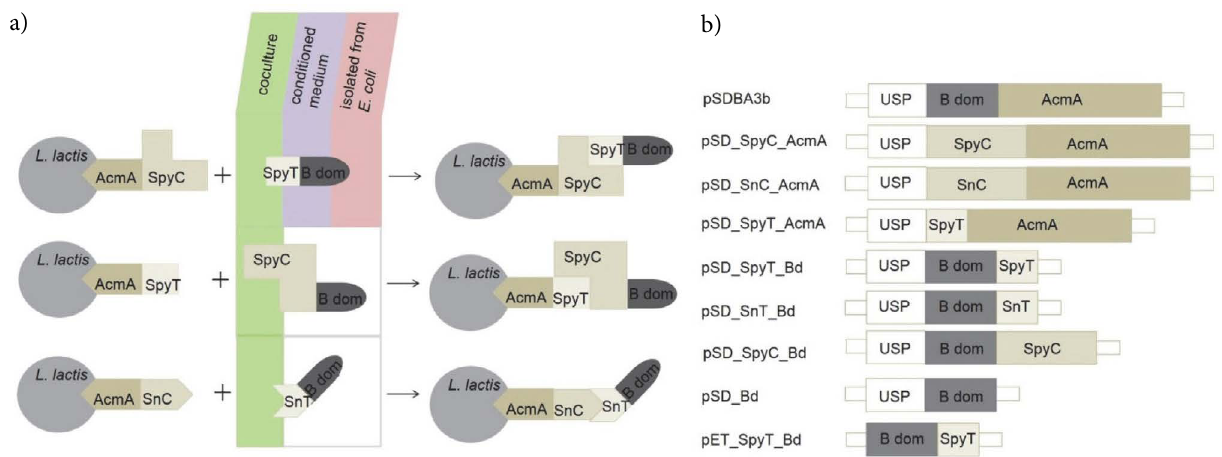
Fig. 1. The principle of surface display of B domain on L. lactis by the formation of isopeptide bond (A), and the gene constructs prepared for its implementation (B). A: Surface displayed SpyCatcher (SpyC), SpyTag (SpyT), or SnoopCatcher (SnC), all anchored via AcmA on L. lactis, bind fu- sion proteins consisting of SpyT, SpyC, or SnoopTag (SnT), respectively, and B domain. The fusion proteins were produced by L. lactis co-culture, were extracted from L. lactis conditioned medium, or were isolated from E. coli . B: Gene constructs for lactococcal surface display and isopeptide bond formation. USP: gene for Usp45 signal peptide for secretion to the growth medium (84 bp). B dom: gene for reporter protein B domain of staphylococcal protein A (174 bp). SpyC: gene for protein SpyCatcher which binds SpyT (348 bp). SnC: gene for protein SnoopCatcher which binds SnT (336 bp). SpyT: gene for peptide SpyTag (39 bp). SnT: gene for peptide SnoopTag (36 bp). AcmA: gene for C-terminal part of AcmA protein-con- taining 3 LysM repeats for surface anchoring to L. lactis (642